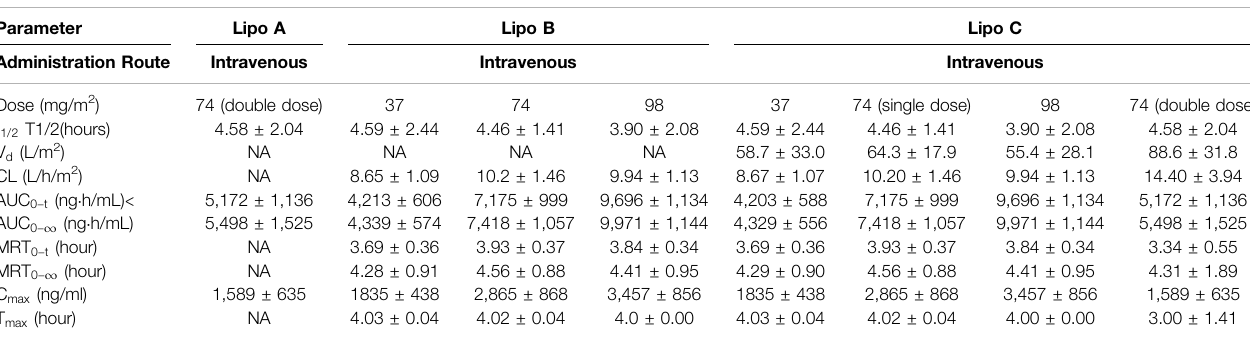
TABLE 3 | Pharmacokinetic data from clinical trials of UA-loading nanoparticles.